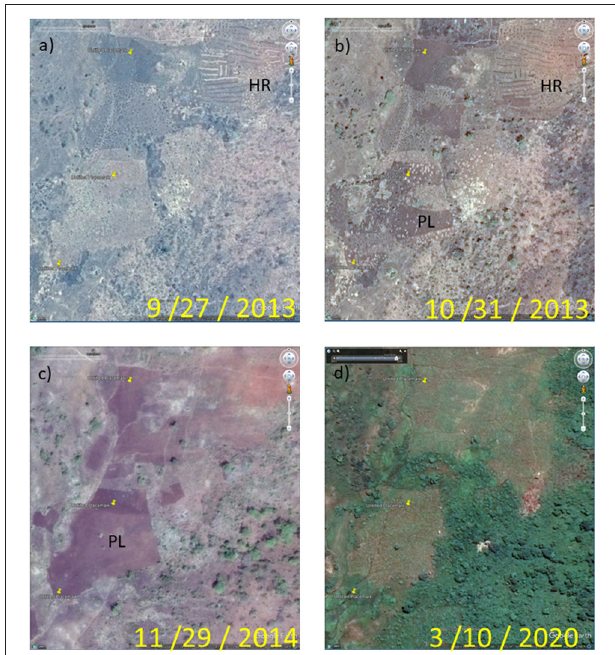
FIGURE 3 | Four different looks in Google Earth Pro at a smallholder agriculture area in east central Malawi near 13.72 ◦ S, 35.1 ◦ E on 9/27/2013 (a) , 10/31/2013 (b) , 11/29/2014 (c) , and 3/10/2020 (d) . Harvest residue (HR) in the north east corner of the 9/27 and 10/31 images identifies this area as cropped. Plowing (PL), exposing dark, smooth soil in 11/29, and to a lesser extent 10/31 identifies this area as cropped. The fine spatial resolution allows for the identification of plant canopies in the southeast portion of the image, the temporal information suggests some of them are evergreen trees, some